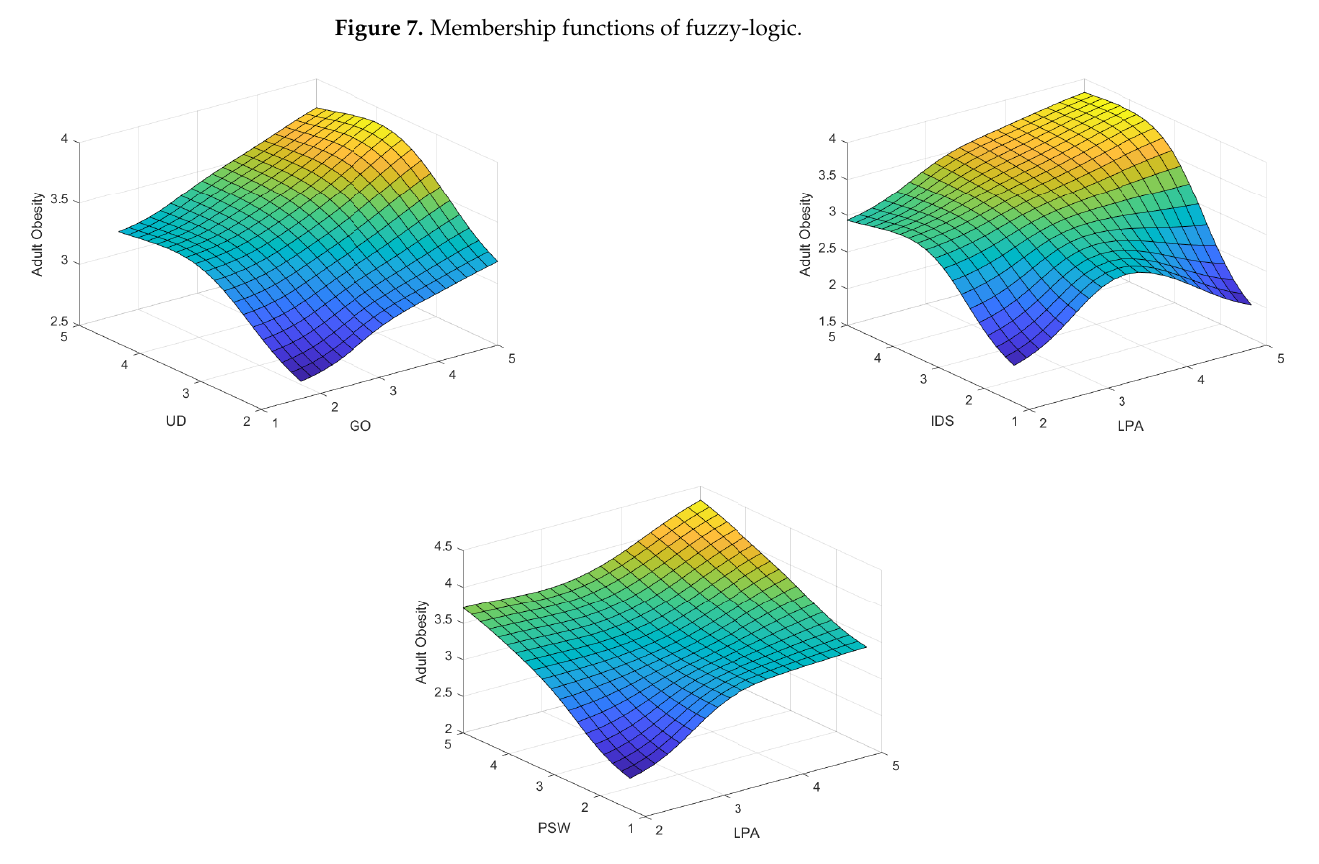
Figure 8. Rule-based system output-3D